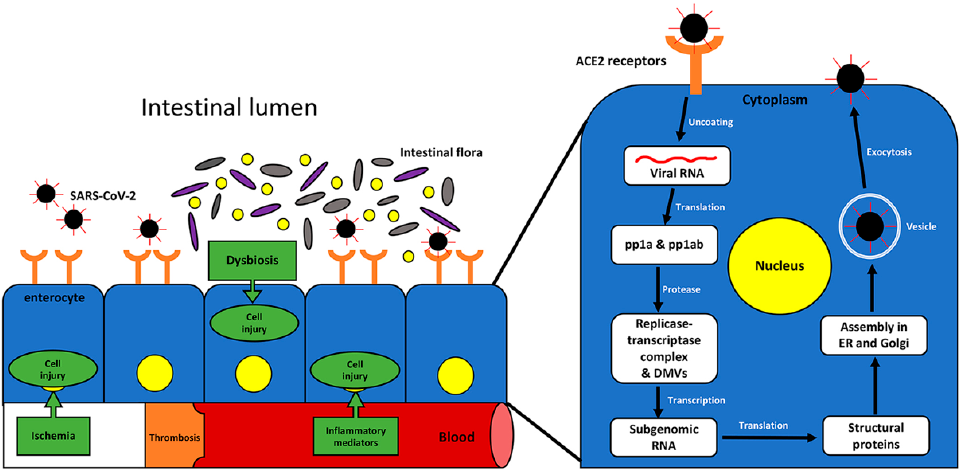
Figure 1. Mechanisms of infection and pathogenesis of COVID-19 in the intestine. The molecular pathogenesis of SARS-CoV-2 infection of epithelial gastrointestinal cells is depicted, including the viral replication cycle.